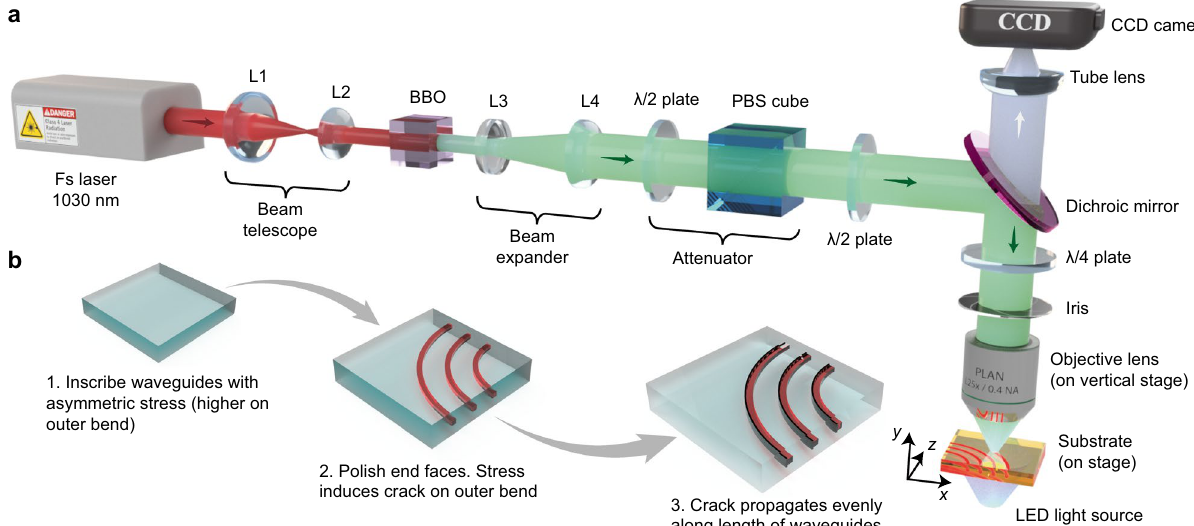
Figure 1. Experimental set up and fabrication procedure. ( a ) Femtosecond writing system for inscription of waveguides. The focusing objective is mounted on a vertical stage to adjust height, and the silica substrate is placed on a two-axis translation stage. ( b ) Procedure for fabricating microcrack along outer edge of curved